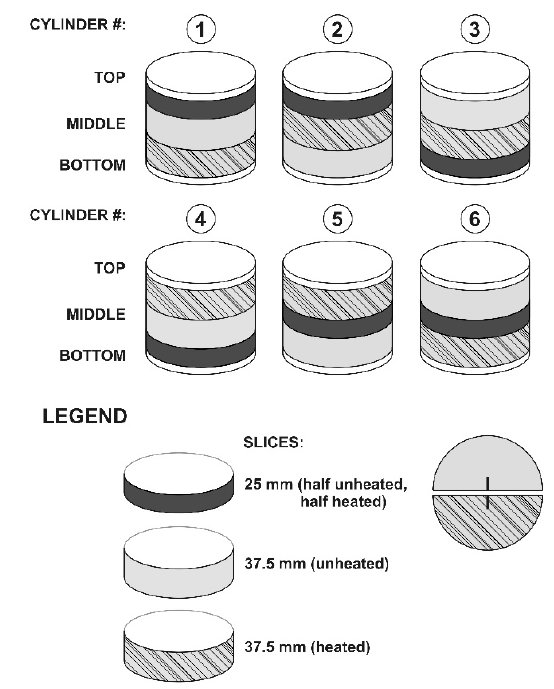
Fig. 1. UHPFRC specimen cutting sequence